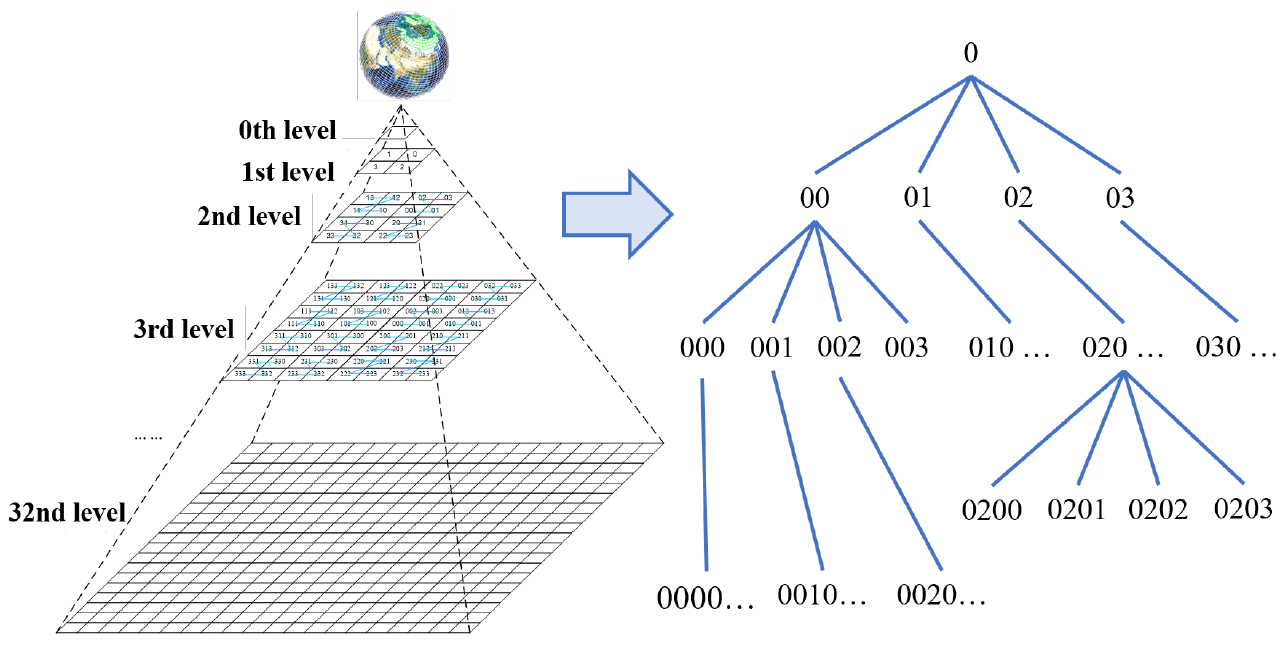
Figure 1. The GeoSOT discrete grid